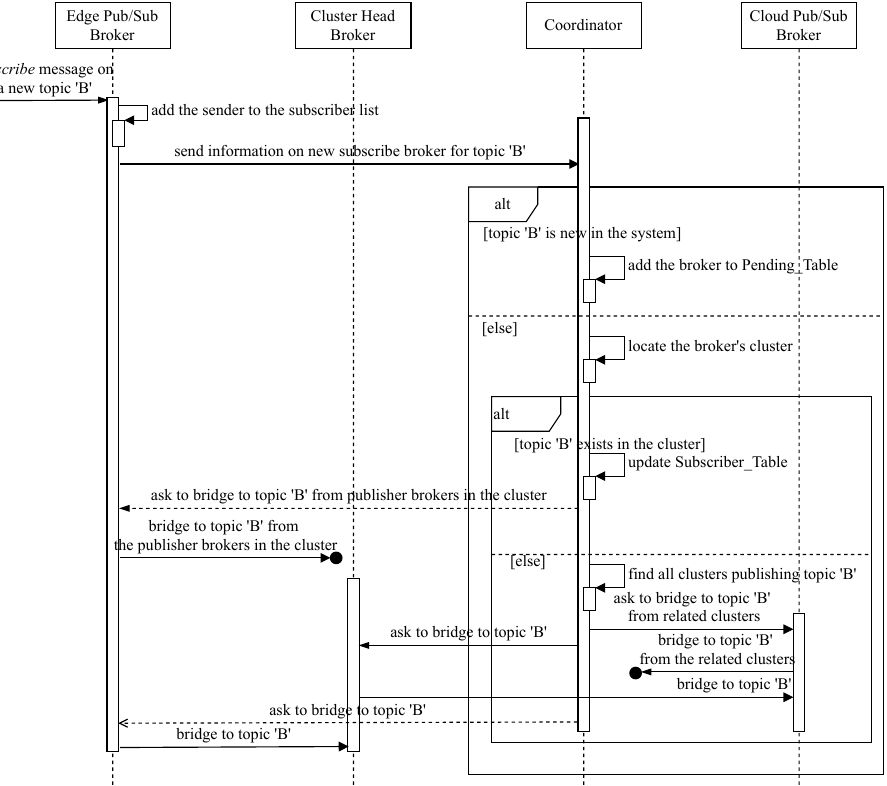
Figure 4. Sequence diagram for bridging joint Subscribe topic